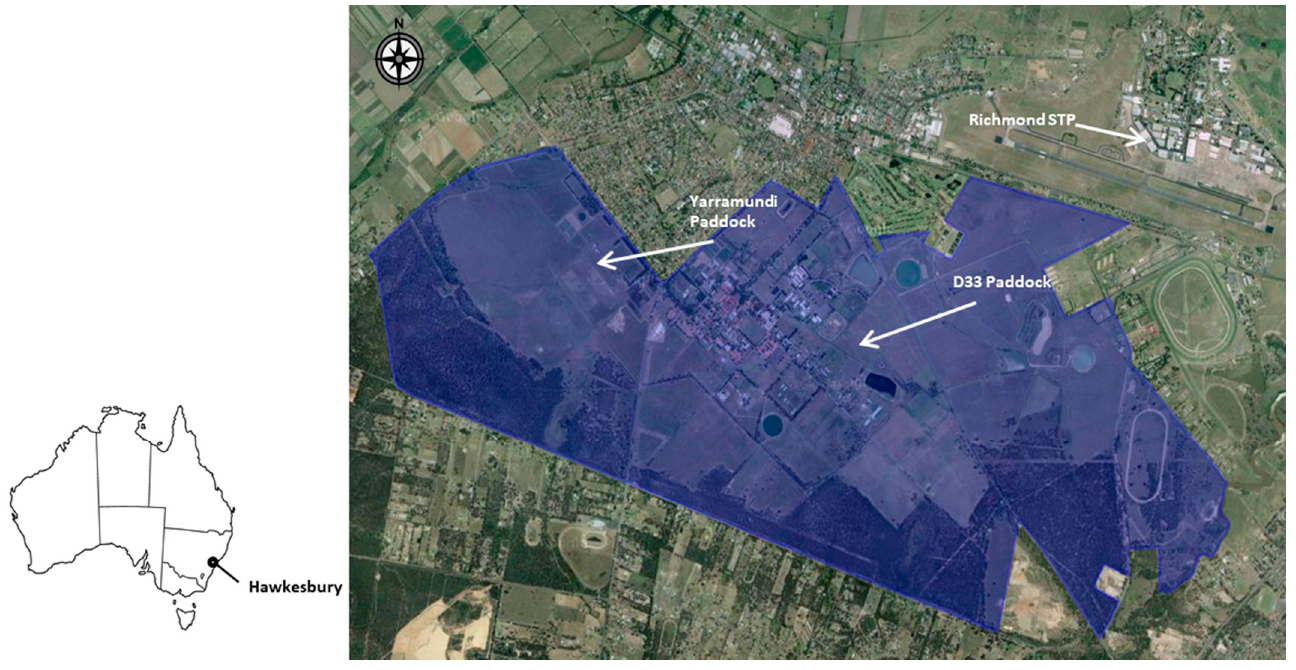
Figure 1. Map showing the location of D33 and Yarramundi paddock within the campus of Western Sydney University, Hawkesbury (the shaded area shows Western Sydney University campus). Table 1. Soil and water analysis method.